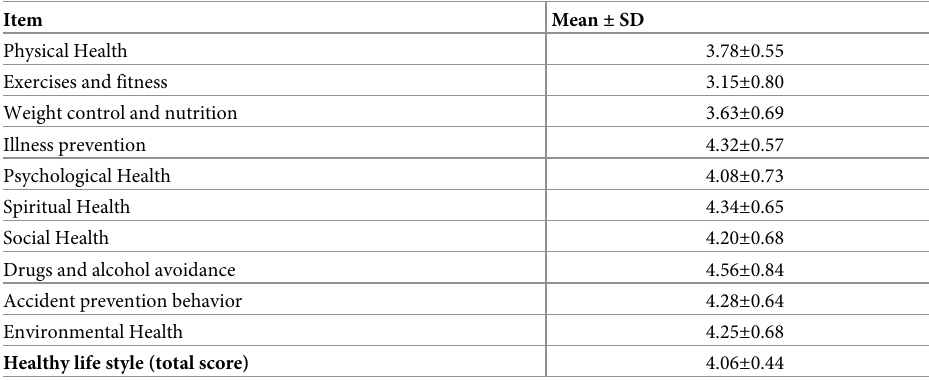
Table 2. Lifestyle scale and subscale scores of the participants.